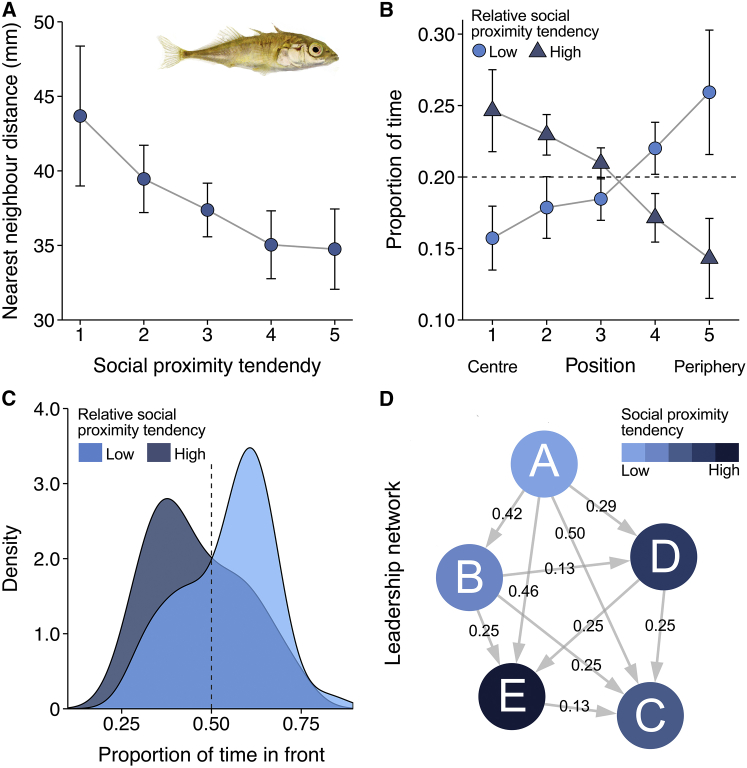
Effect of Social Proximity Tendency on Spatial Positioning and Leadership(A) Fish nearest neighbor distance in groups as a function of their social proximity tendency, shown in five equally sized categories (mean ± 2 SEM; n = 120 fish).(B) Proportion of time fish occupied the most central to the most peripheral position in the group, calculated for each frame and averaged per individual across all frames (mean ± 2 SEM).(C) Density plot of the proportion of time individuals spent in front of the group center for the full 30 min trial.(D) Visualization of a leadership network in terms of propagation of speeding changes of one randomly selected group. Numbers indicate the average temporal delay in seconds and arrows point in the direction of propagation; see Figure S3.For plots (B) and (C), individuals were evenly distributed into three categories, with the intermediate category not shown for clarity. All data were analyzed as a continuous variable. See also Figures S2 and S4 for model simulations.